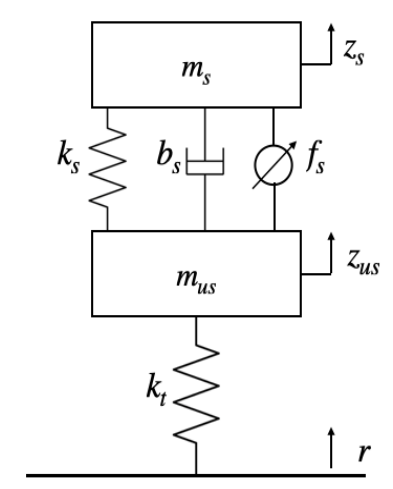
Figure 1. Active Suspension System.